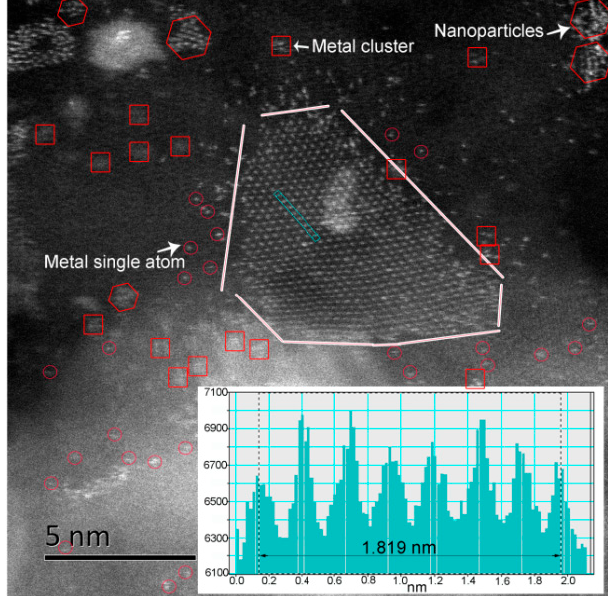
Figure 1. Aberration-corrected scanning transmission electron microscope high-angle annular dark-field (STEM-HAADF) image of Cat A at atomic-resolution and inset corresponds to the line profiles. The interatomic spacing of active phase as revealed by the line profile is 2.60 Å (1.819 nm/7).